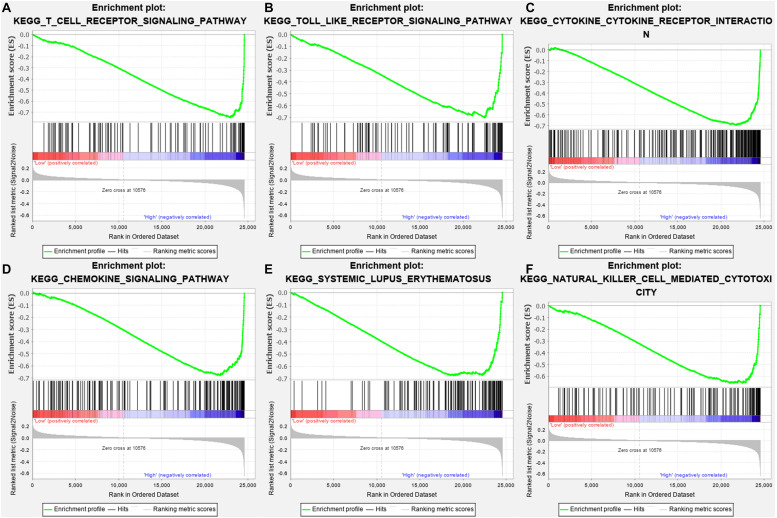
Gene-set enrichment analysis (GSEA) analysis for gene sets related with CTLA4 expression. (A–F) The gene sets of “T cell receptor signaling pathway,” “Toll like receptor signaling pathway,” “Cytokine–cytokine receptor interaction,” “Chemokine signaling pathway,” “Systemic lupus erythematosus,” and “Natural killer cell-mediated cytotoxicity” were enriched in ccRCC samples with CTLA4 highly expressed.